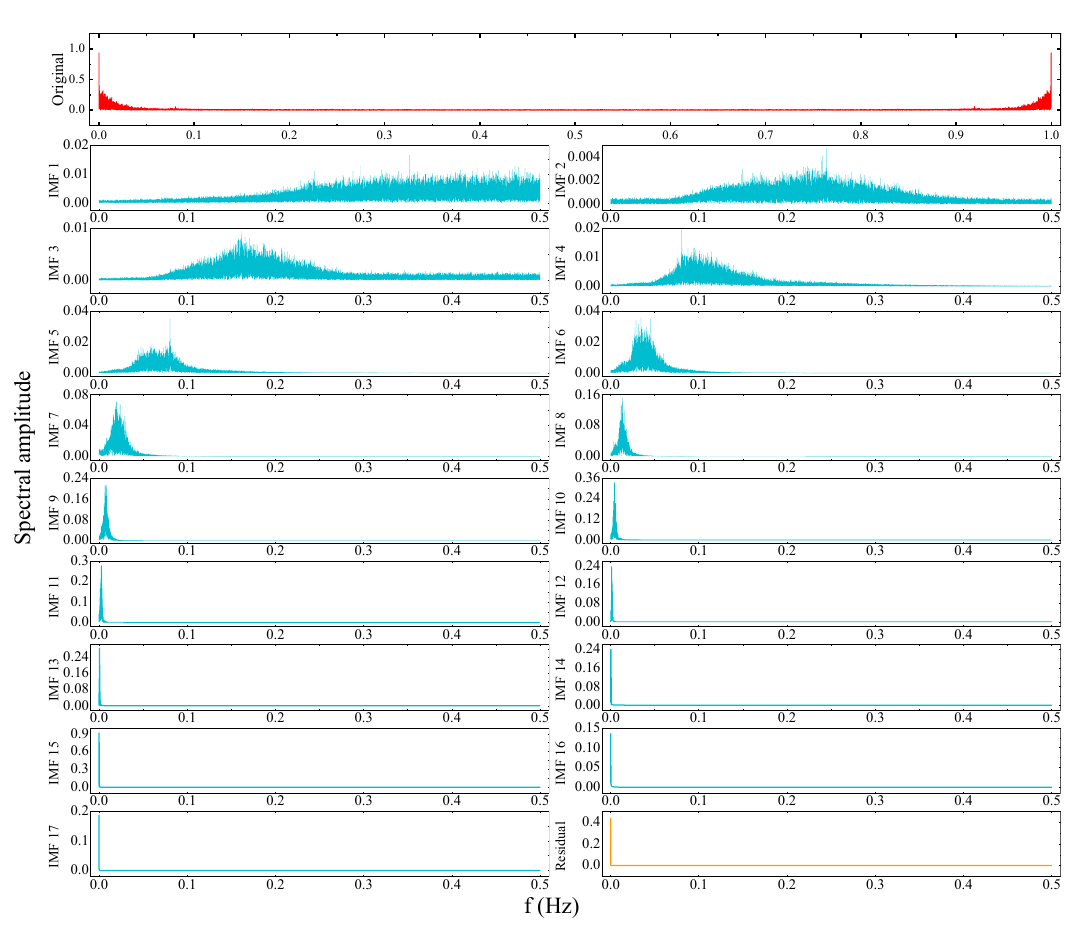
Figure 11. Comparison of ShiDao effective data in the frequency domain for the IMFs component of SWH sequence by CEEMDAN algorithm.